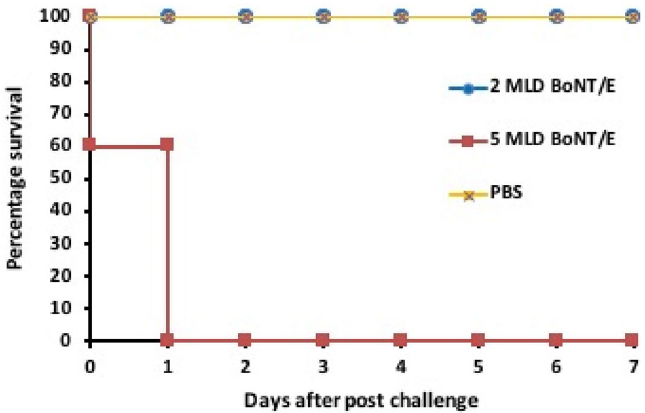
Figure 8. In vivo protection study: the immunized animals were challenged with PBS (control), BoNT/A, B, E and F serotypes. This graph illustrates the immunized animals examined for 7 days after the challenge, immunized mice showed complete protection when injected with 2x MLD of